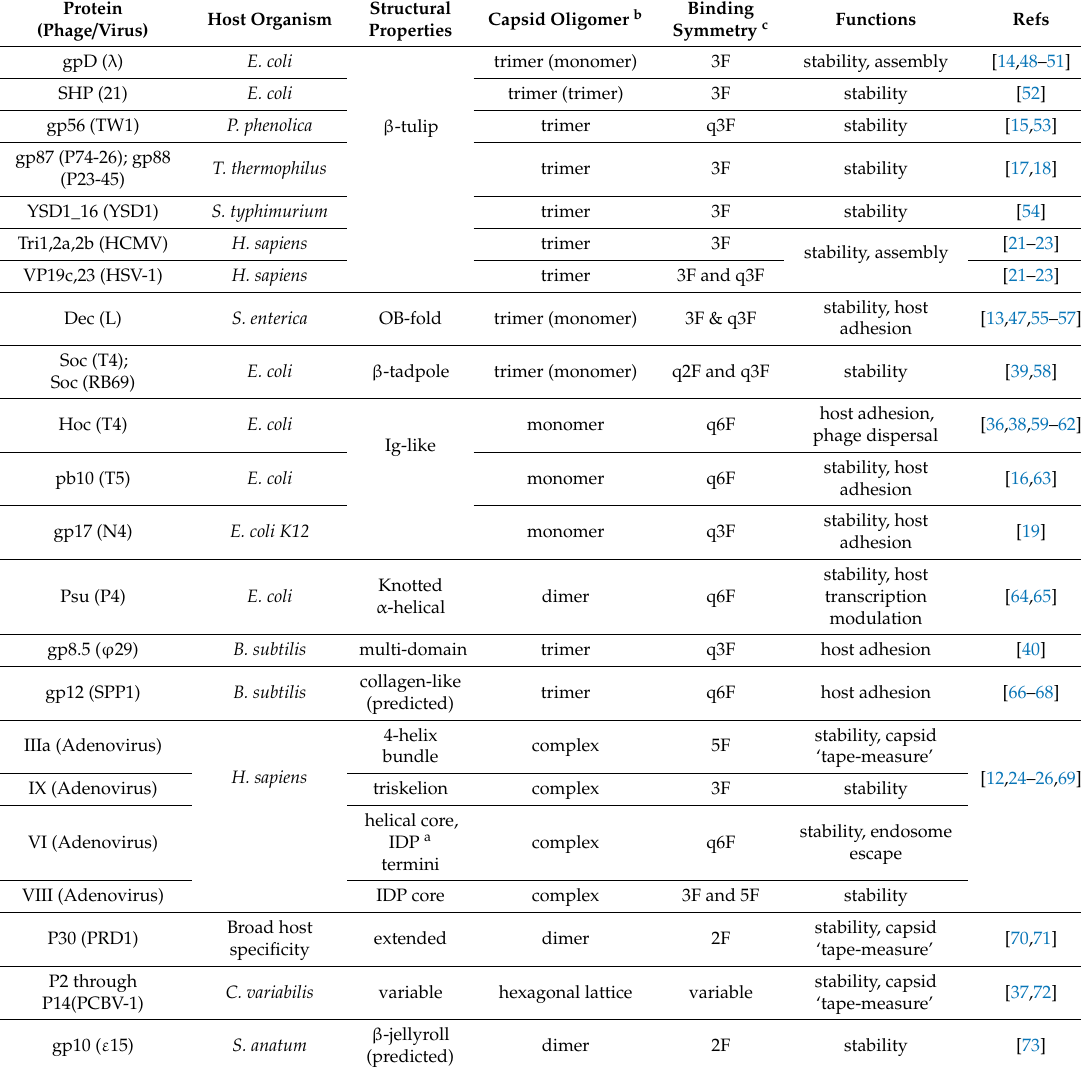
Table 1. Properties and functions of decoration